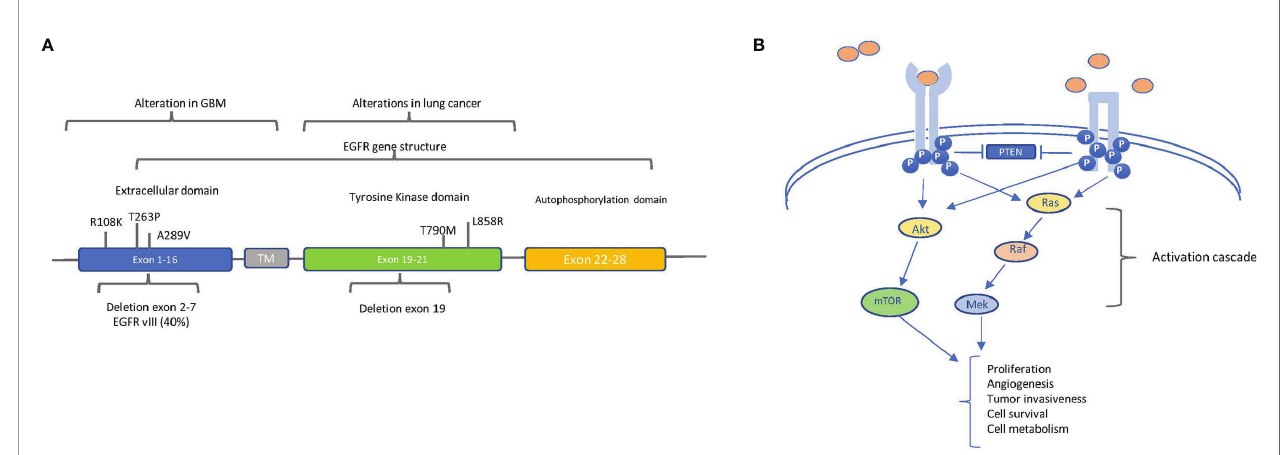
FIGURE 4 | The main oncogenic alterations of EGFR: (A) Localization of relevant alterations within the epidermal growth factor receptor (EGFR) gene in glioblastoma (GBM) and lung cancer. The structural organization of EGFR exons and respective domains is shown. The principal point mutations and deletions in GBM (in exons 1 – 16, extracellular domain) and in lung cancer (in exons 19 – 20, tyrosine kinase domain) are indicated. The frequency of intragenic deletion in exons 2 to 7 (leading to variant EGFRvIII) is indicated. (B) EGFR (left) and EGFRvIII (right) signaling pathways. EGFR and EGFRvIII trigger the AKT and MAPK pathways, but ligands (pink circles) can bind and activate only EGFR, whereas EGFRvIII is constitutively active in a ligand-independent manner. Block arrows indicate inhibition. Point arrows indicate activation. The downstream processes of the activation cascade are